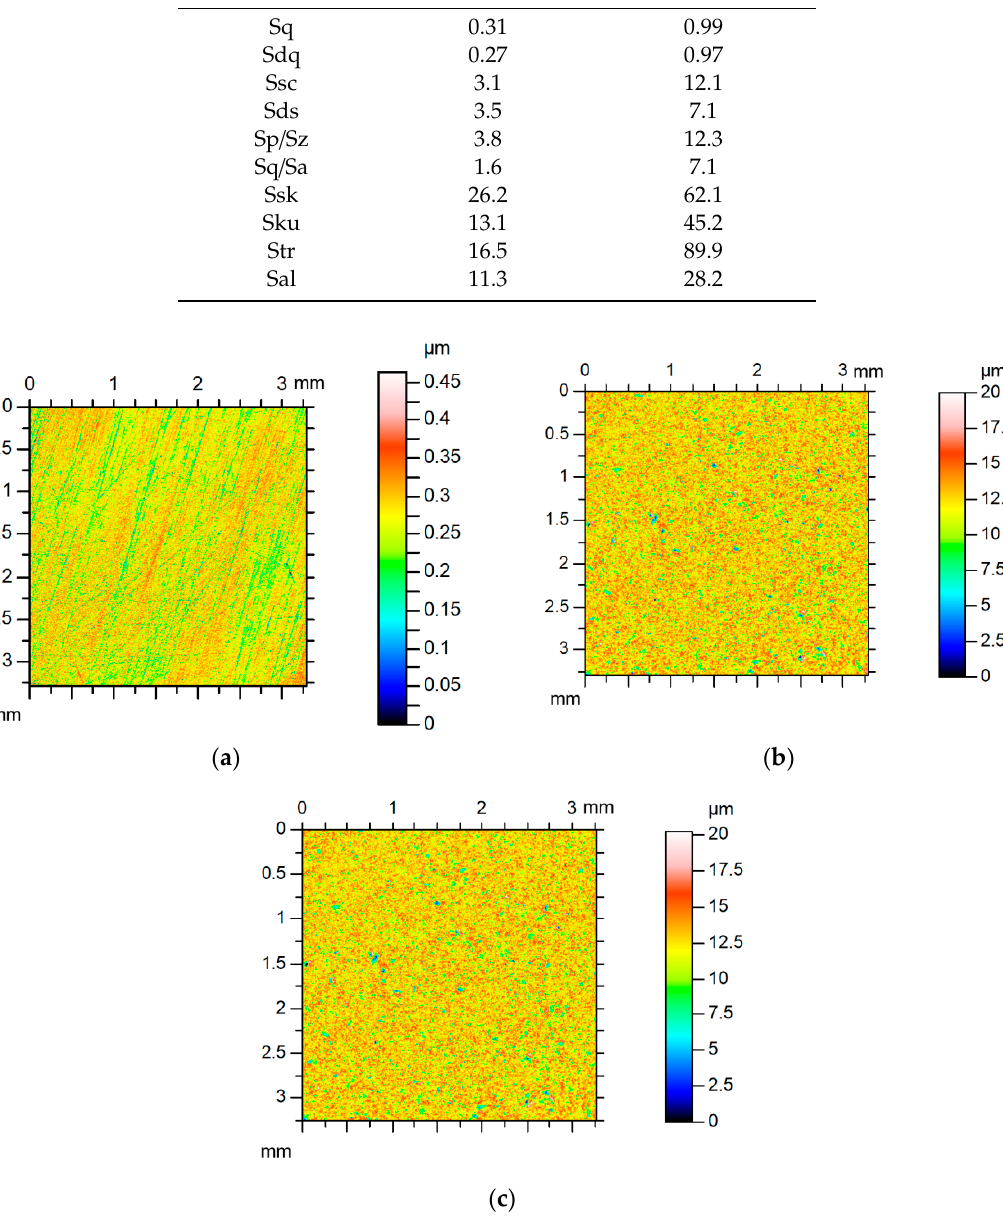
Table 2. Relative errors of parameters predictions.